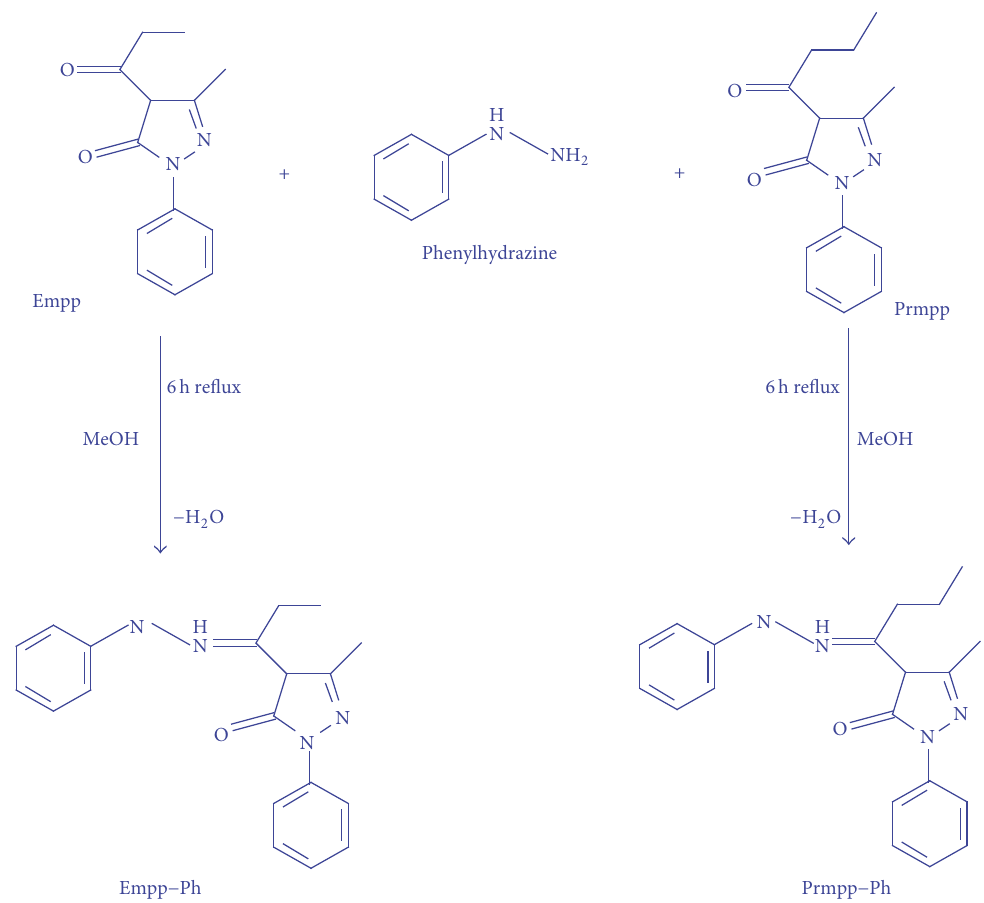
Figure 1: Synthesis of